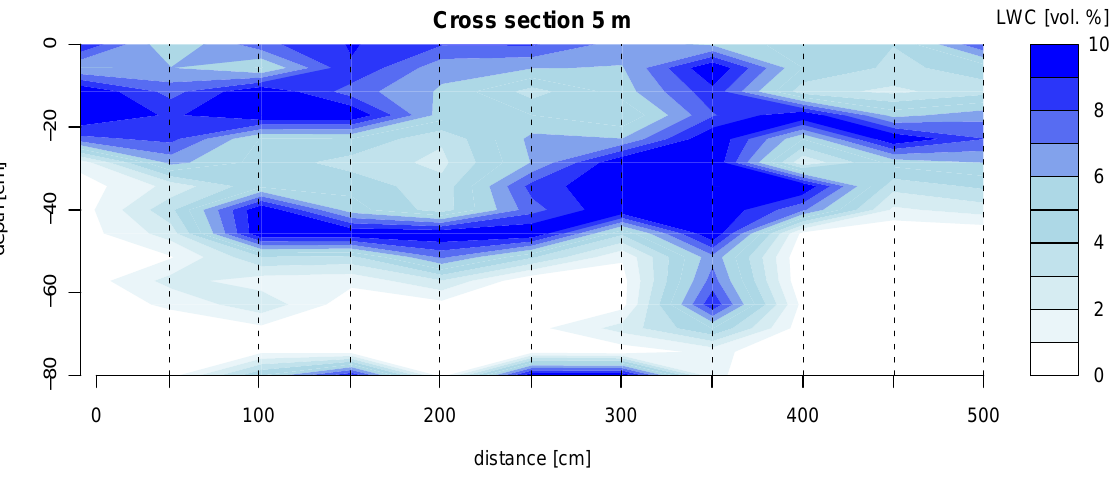
Fig. 5. Contour plot showing cross-section of snow wetness ( θ ) to a depth of 80 cm over 5 m wide areas across the slope. Measure- ments were conducted at horizontal intervals of 50 cm (lines) with a vertical spacing of 5 cm. 4 April 2009, S aspect, 2660 m, 30 ◦ . θ , measured with the Snow Fork, is corrected by -0.8 vol.% (this corresponds to the median offset in dry snow).